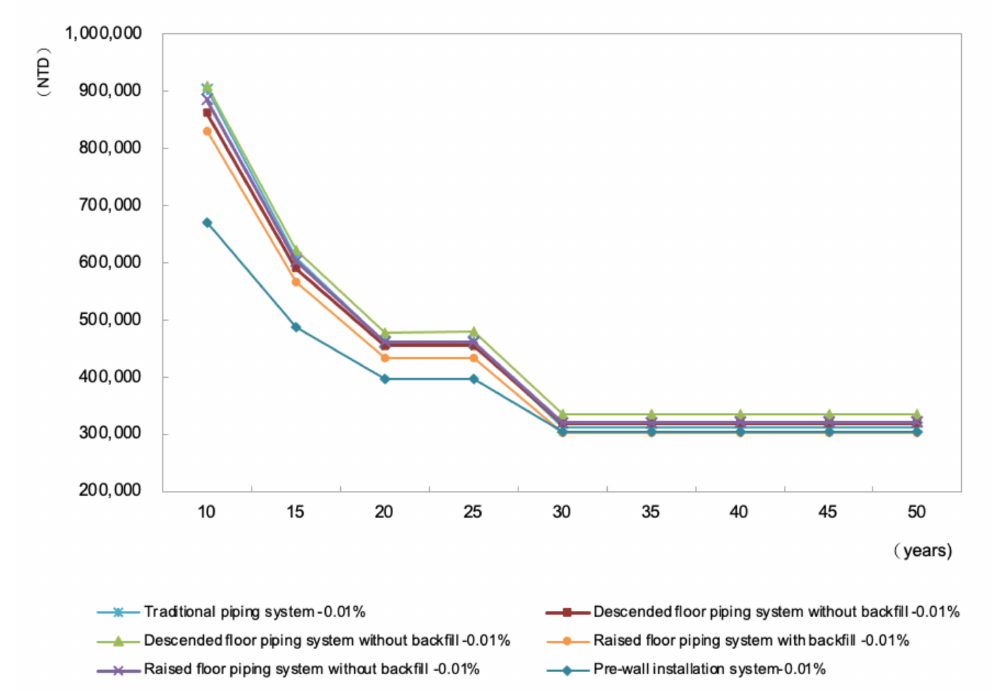
Figure 6. Life cycle costs for the complete replacement of pipelines in the four types of bathroom piping systems with discount rate of − 0.01%.